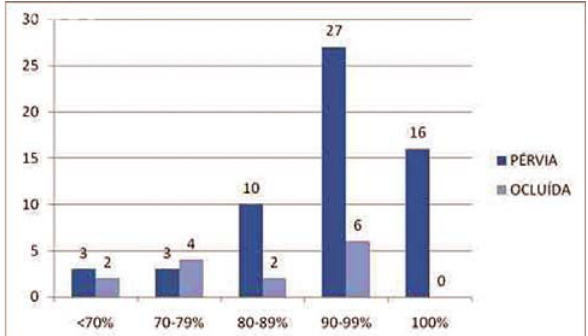
Fig. 6 - Evolução da perviedade dos enxertos de AR, quanto à lesão obstrutiva da coronária revascularizada – grupo anastomose em “Y” (n=73)